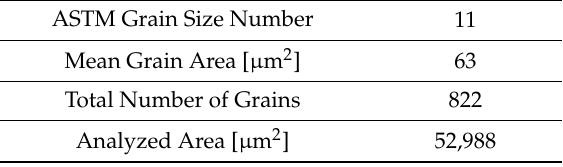
Table 2. Titanium Grade 2 grain size parameters.